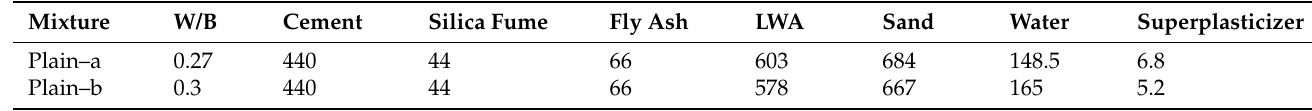
Table 3. The mix proportions of plain LWAC (kg/m 3 ).